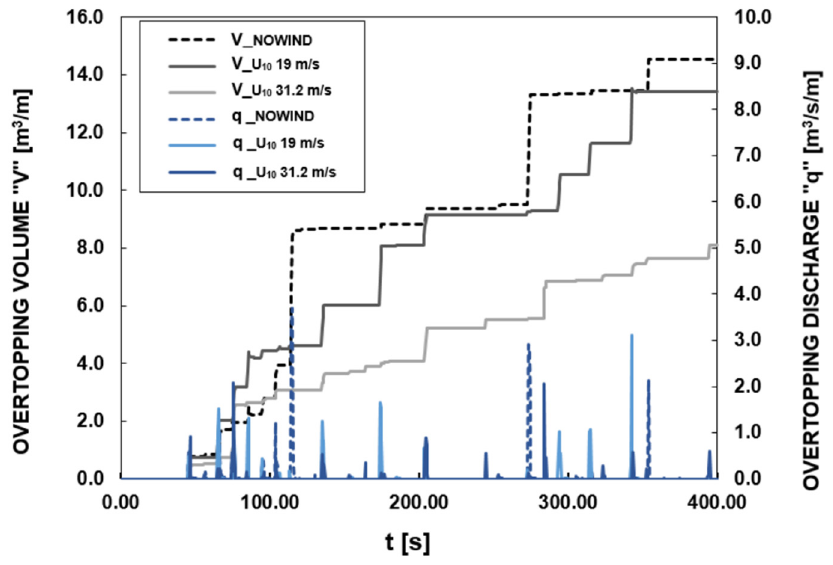
Figure 10. Cumulative overtopping volumes and wave overtopping discharges for different wind velocity, TEST_1 and Rc = +10.00 m.